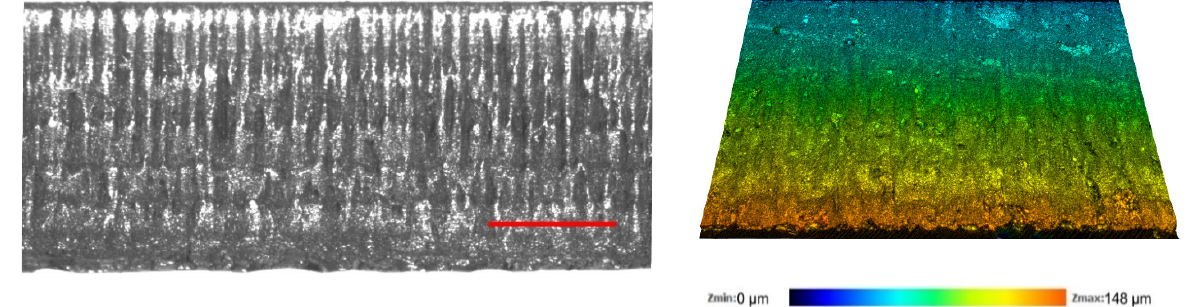
Figure 18. Optical micrograph ( left ) and the topography ( right ) of the cut sidewall produced in water at 15.5 W. The scale bar in the left panel represents 200 µm.